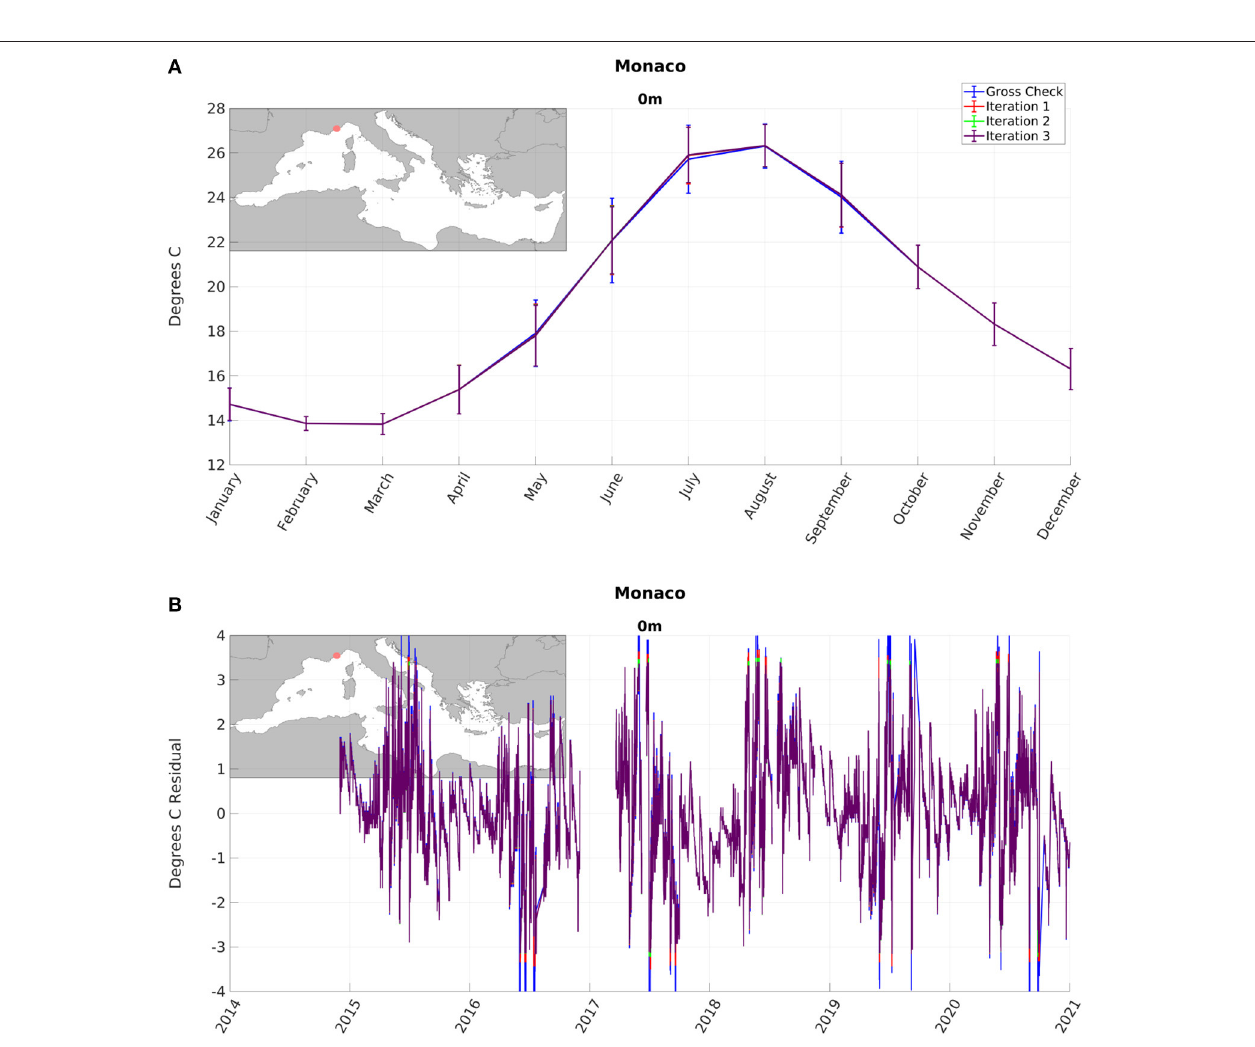
FIGURE 6 | Surface temperature at Monaco station: (A) monthly climatology and standard deviation; (B) residuals. The lines show the input data (passed gross QC) to the recursive statistical QC and the output of its three iterations.